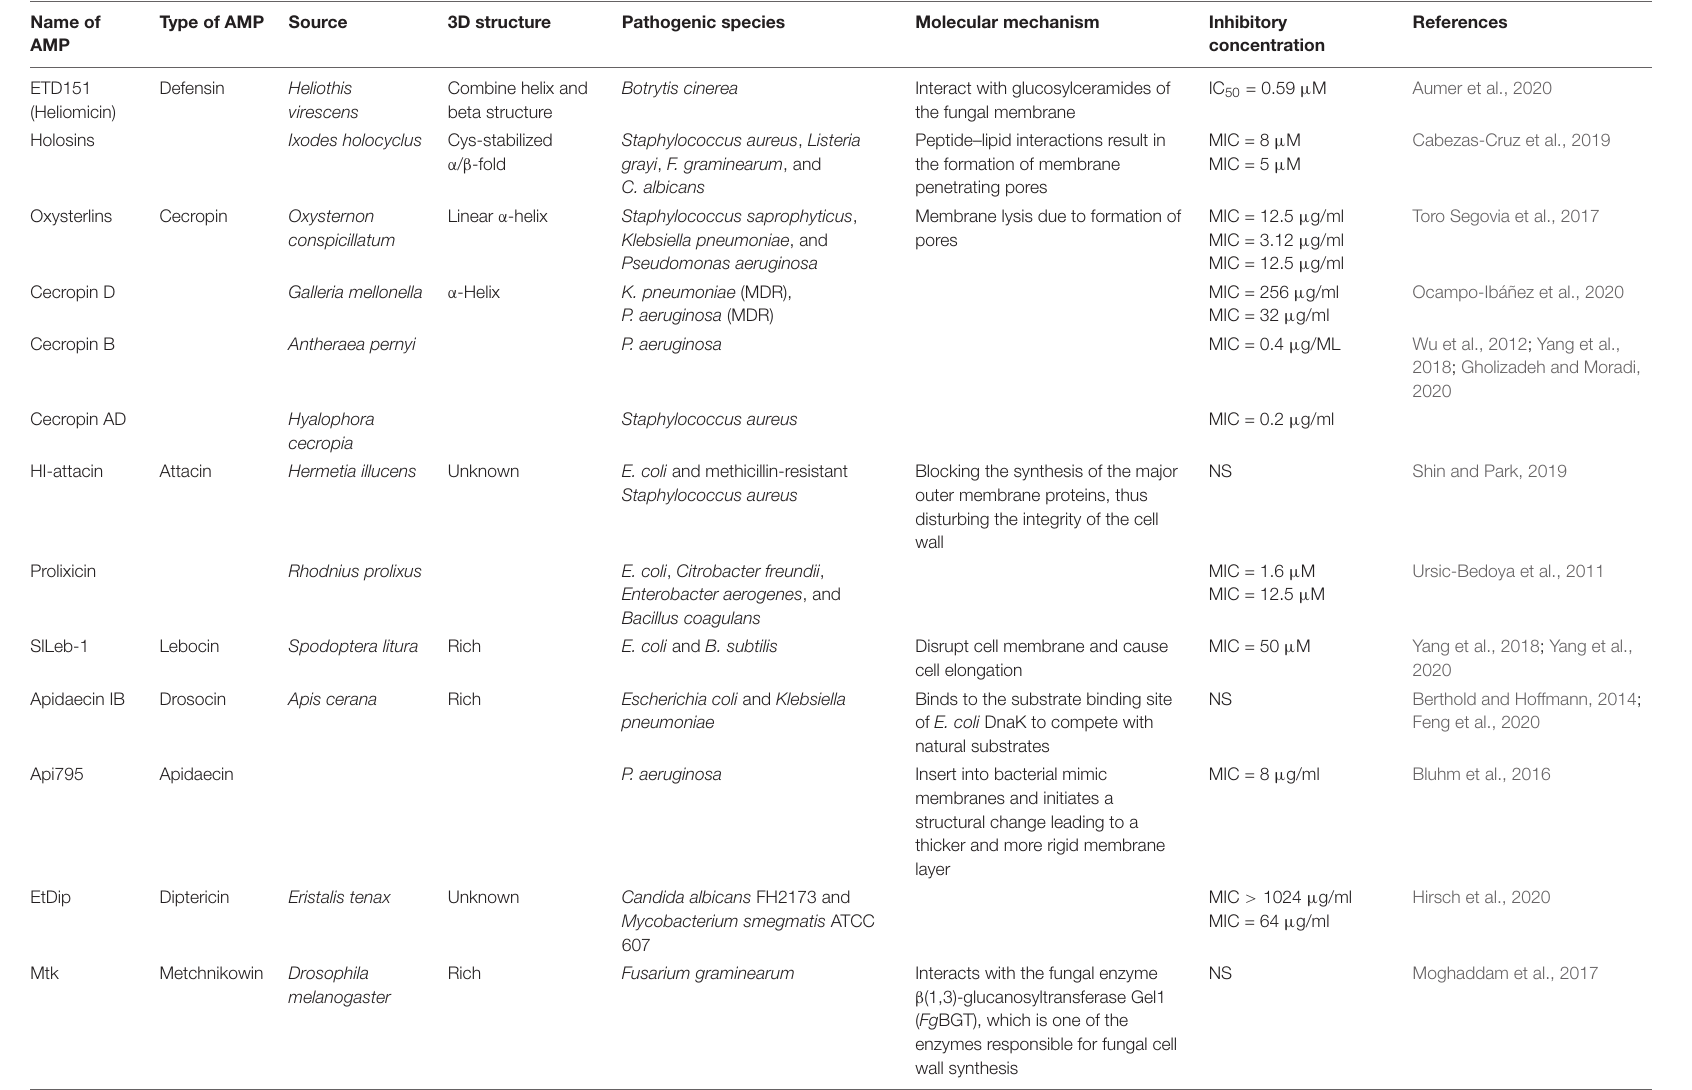
TABLE 1 | Recently identified insect AMPs with their mechanism of